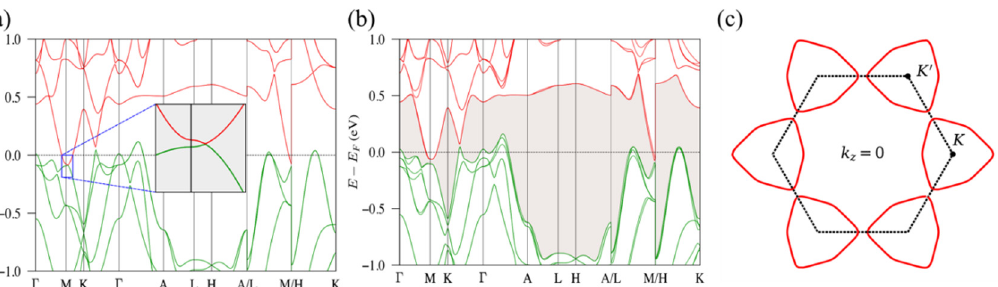
Figure 5. Electronic band structure and of ZrRuAs at 0.3 GPa without ( a ) and with ( b ) SOC. Green and red lines are valances and conduction bands. The inset in ( a ) shows a crossing along M ‐ K in the absence of SOC. The shadow area in ( b ) indicates a continuous gap between valance and conduction bands when the SOC is turned on. ( c ) The nodal lines are presented on the k z = 0 plane when SOC is turned off. Red lines are nodal lines. Dashed lines indicate the first Brillouin Zone.